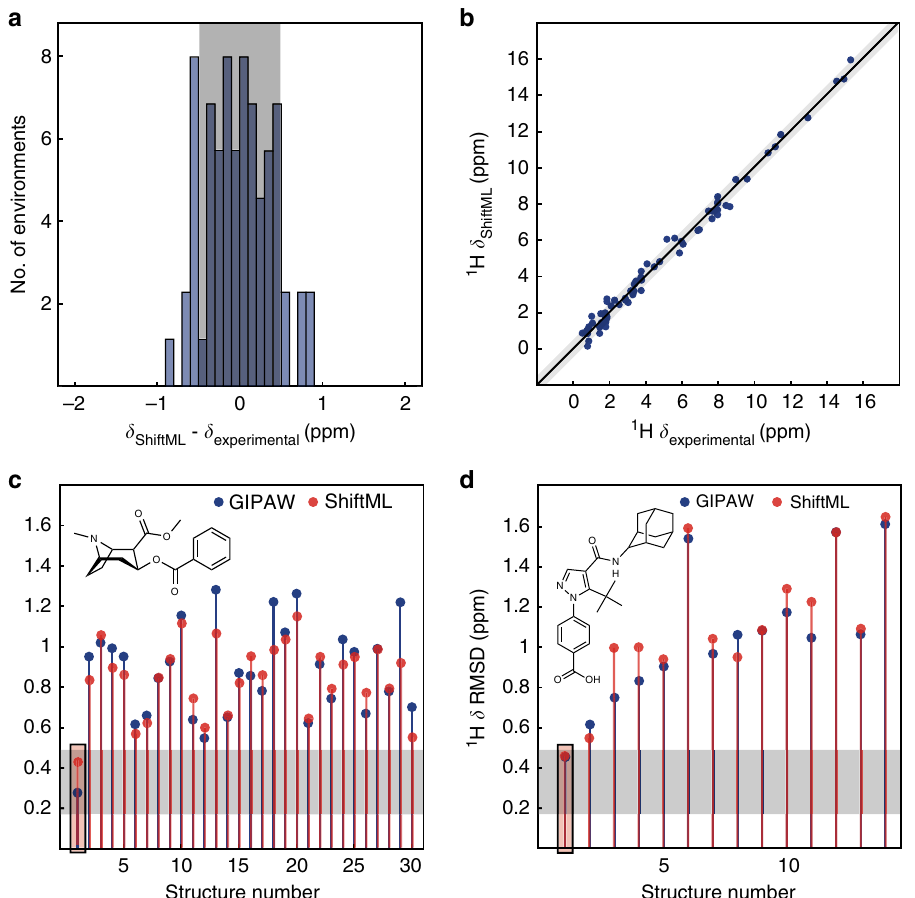
Fig. 5 Comparison of ShiftML to experimentally measured shifts. a Histogram showing the distribution of differences between experimentally measured 1 H chemical shifts and 1 H chemical shifts calculated with ShiftML for six different crystal structures (see Supplementary Methods for the structures and numerical values of the shifts). b Scatterplot showing the correlation between these experimentally measured 1 H chemical shifts and shifts calculated with ShiftML. c , d Comparison between calculated and experimental 1 H chemical shifts for the most stable structures obtained with CSP for cocaine ( c ) and AZD8329 ( d ). For each candidate structure an aggregate RMSE is shown between experimentally measured shifts and shifts calculated using either GIPAW (blue) or ShiftML (red). The gray zones represent the con fi dence intervals of the GIPAW DFT 1 H chemical shift RMSD, as described in the text 13 , and candidates (in c and d ) that have RMSEs within this range would be determined as correct crystal structures using a chemical shift-driven solid-state NMR crystallography